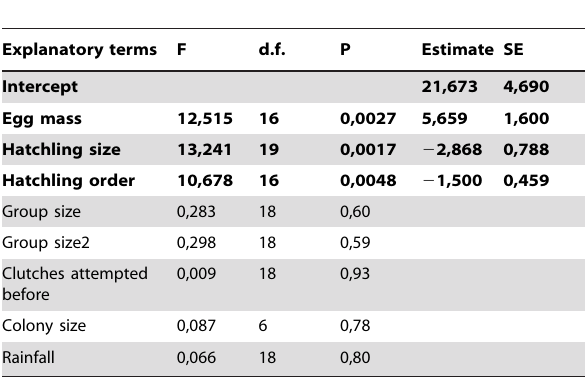
Table 7. Factors affecting fledgling